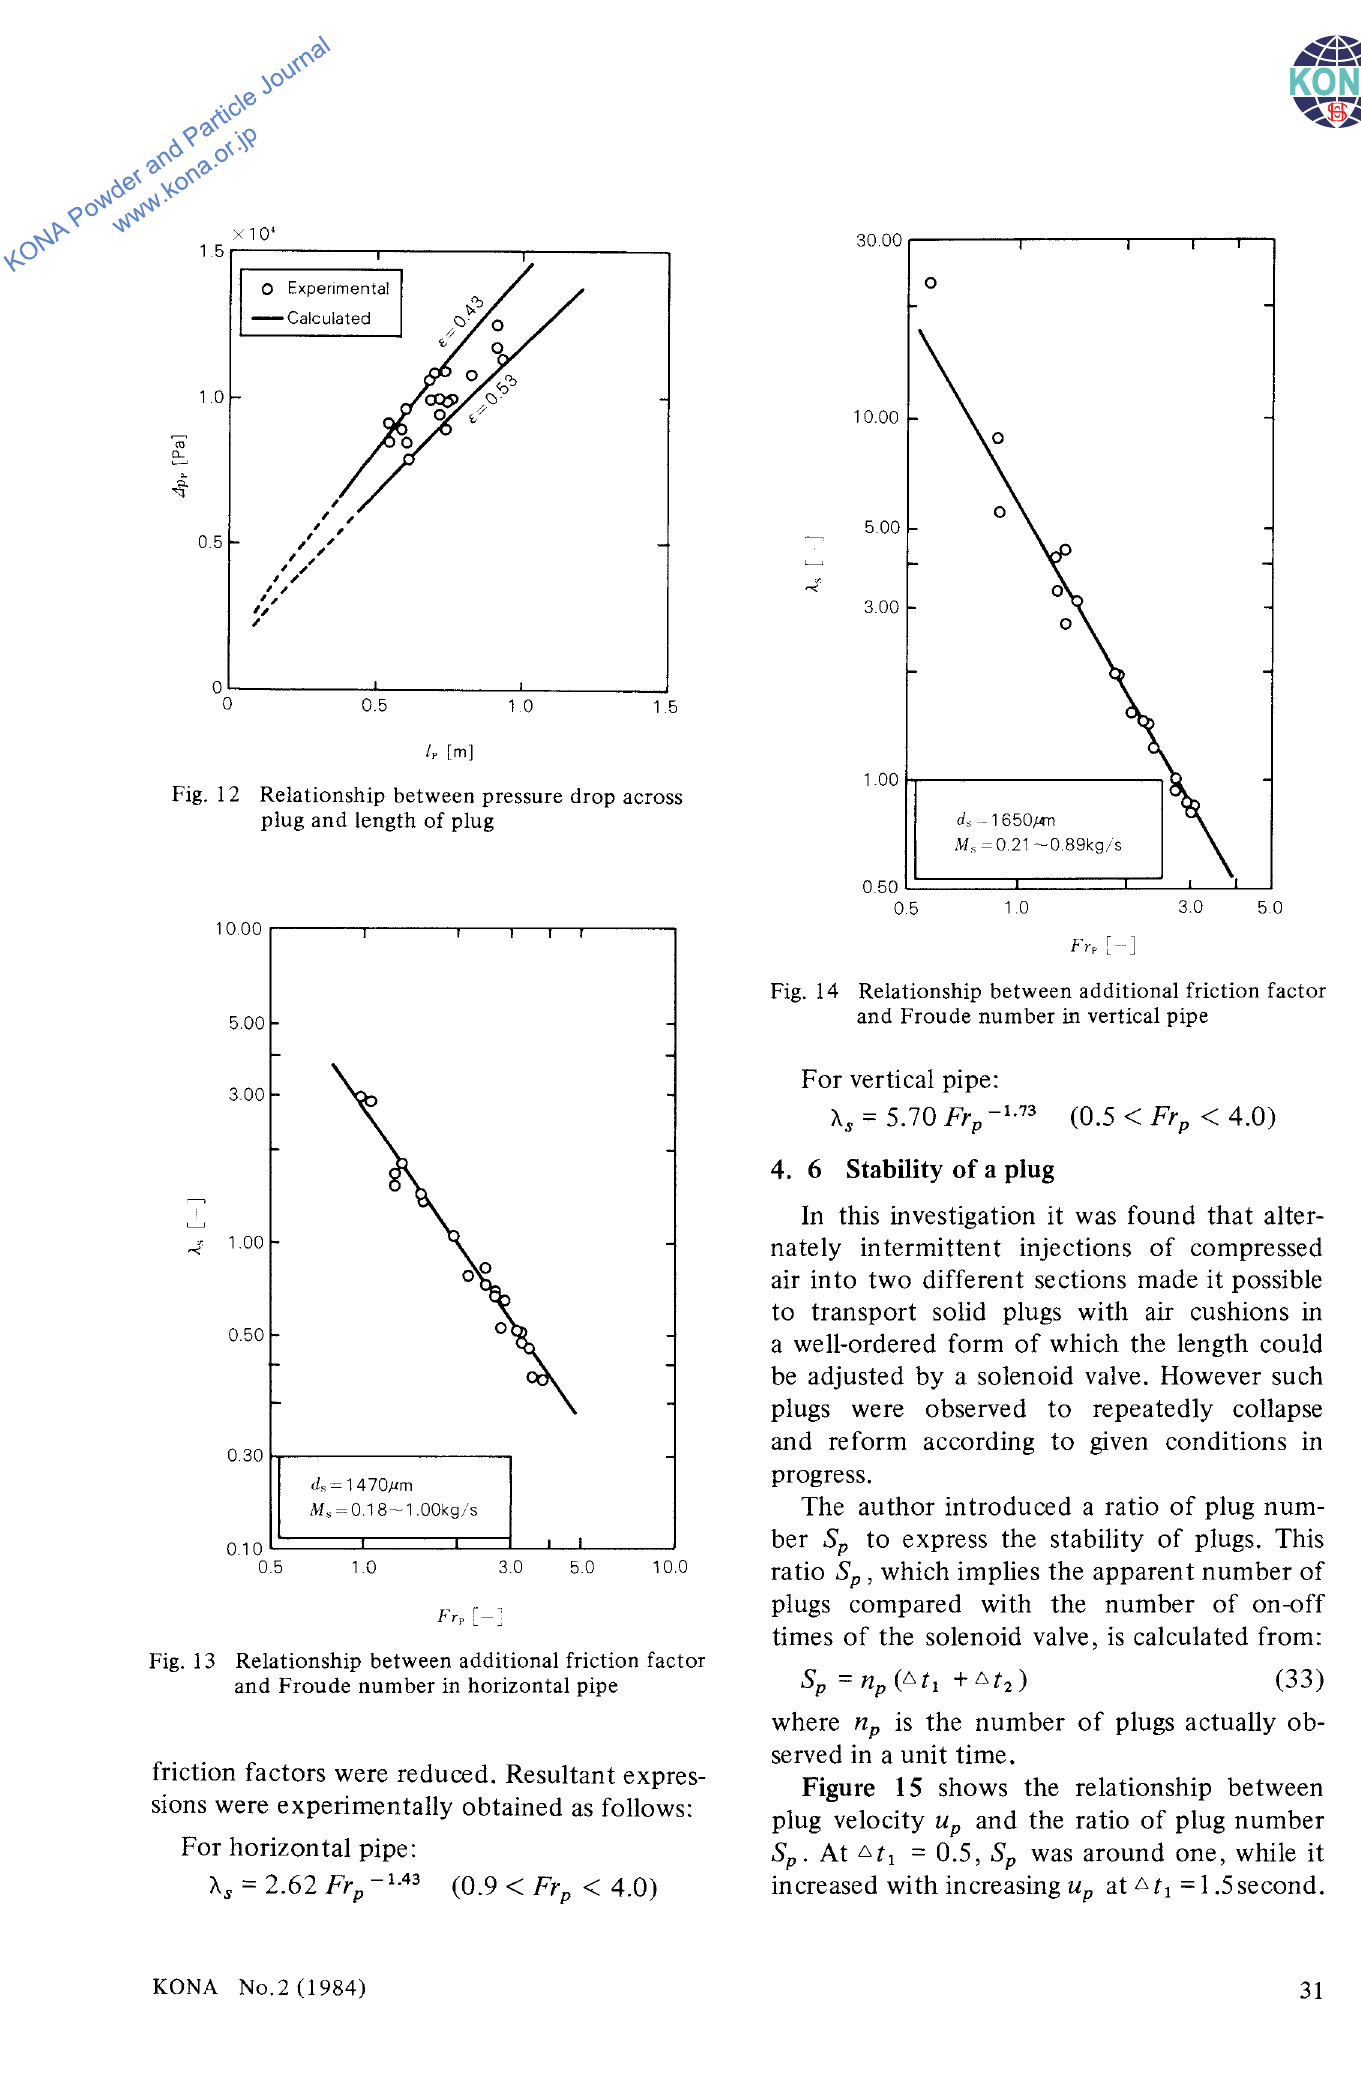
friction factors were reduced. Resultant expres